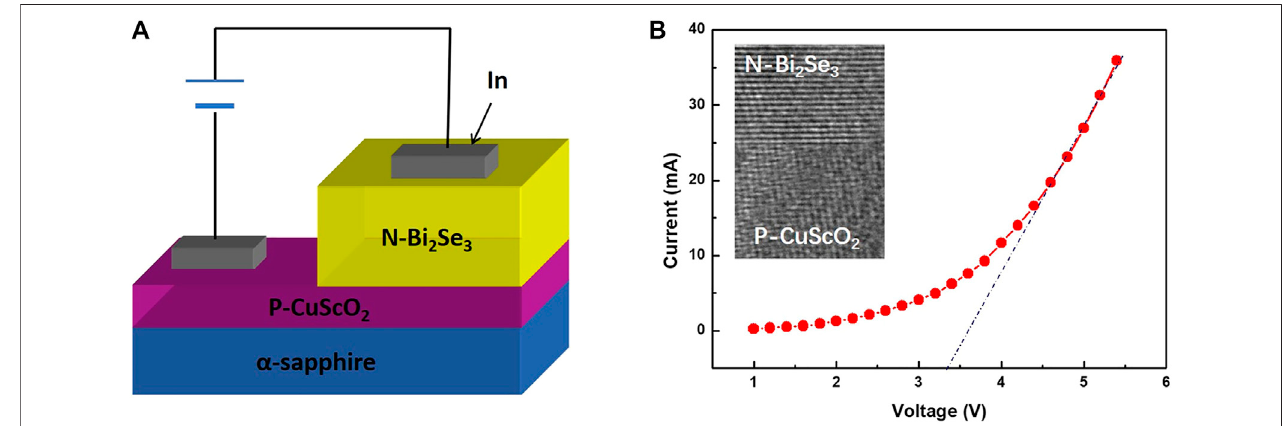
FIGURE 6 | (A) Schematic structure of N-Bi 2 Se 3 /P-CuScO 2 heterojunction diode device. (B) Current ( I ) — voltage ( V ) characteristics of N-Bi 2 Se 3 /P-CuScO 2 diode device. The inset in (B) shows the cross-sectional HREM image of N-Bi 2 Se 3 /P-CuScO 2 interface.